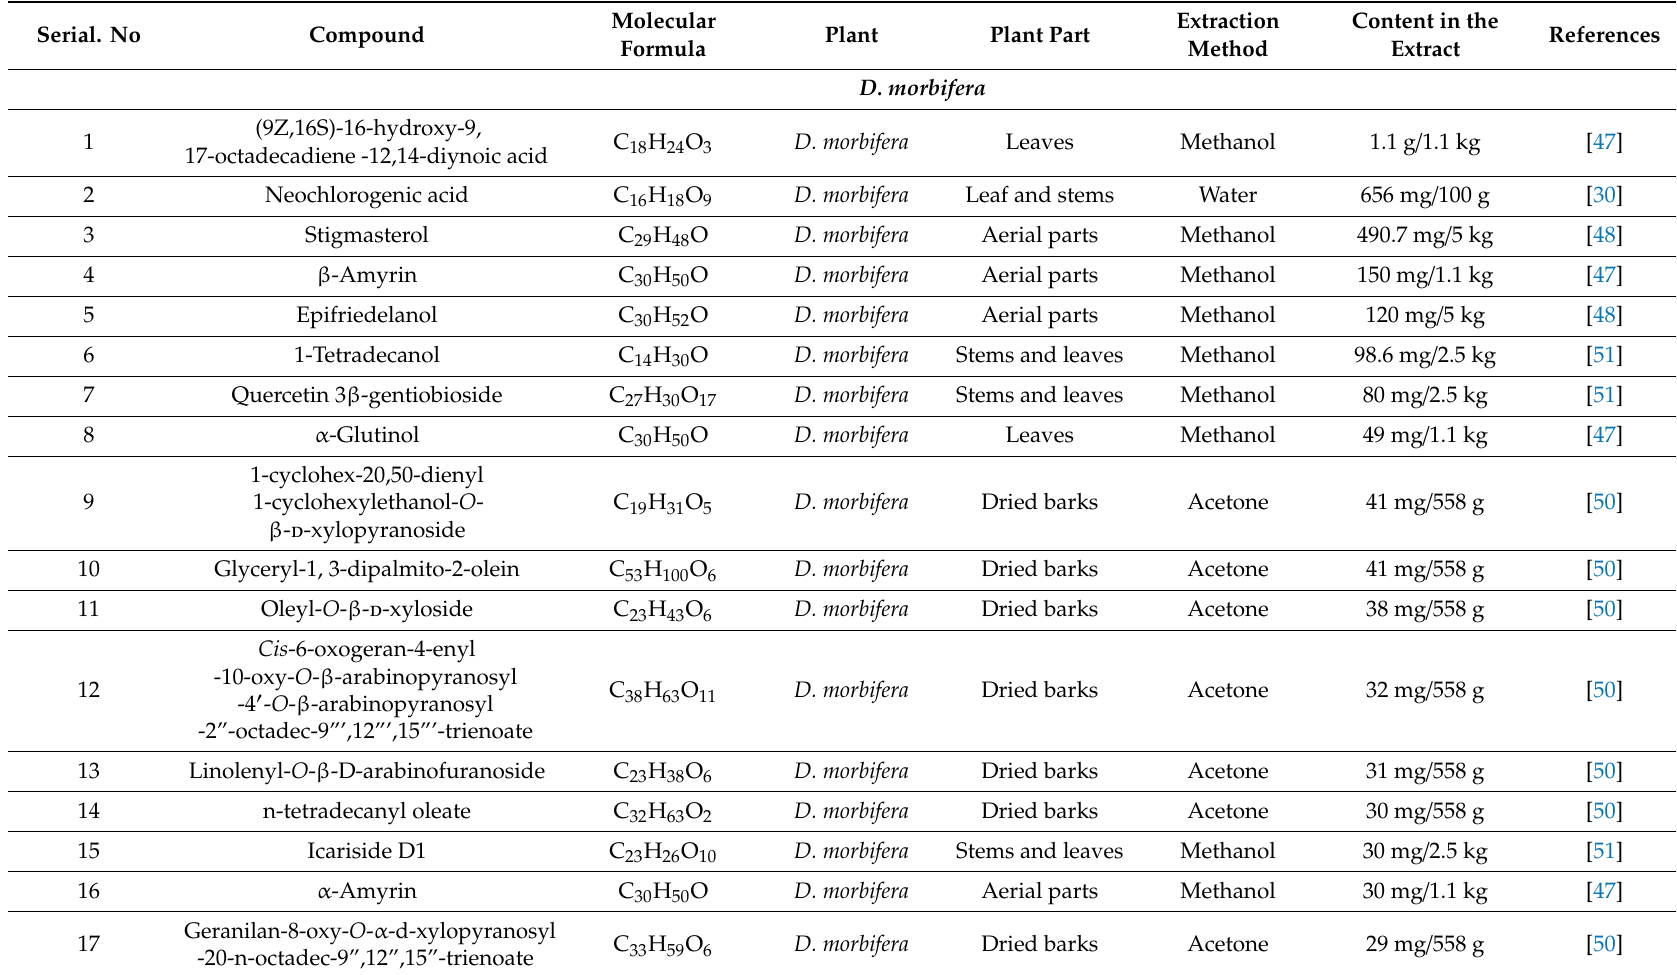
Table 1. Phytochemical constituents identified from D.